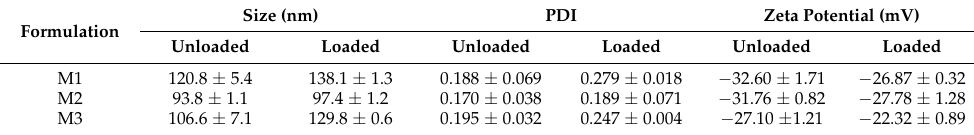
Table 2. Size (nm), PDI and zeta potential (mV) of the selected microemulsions.